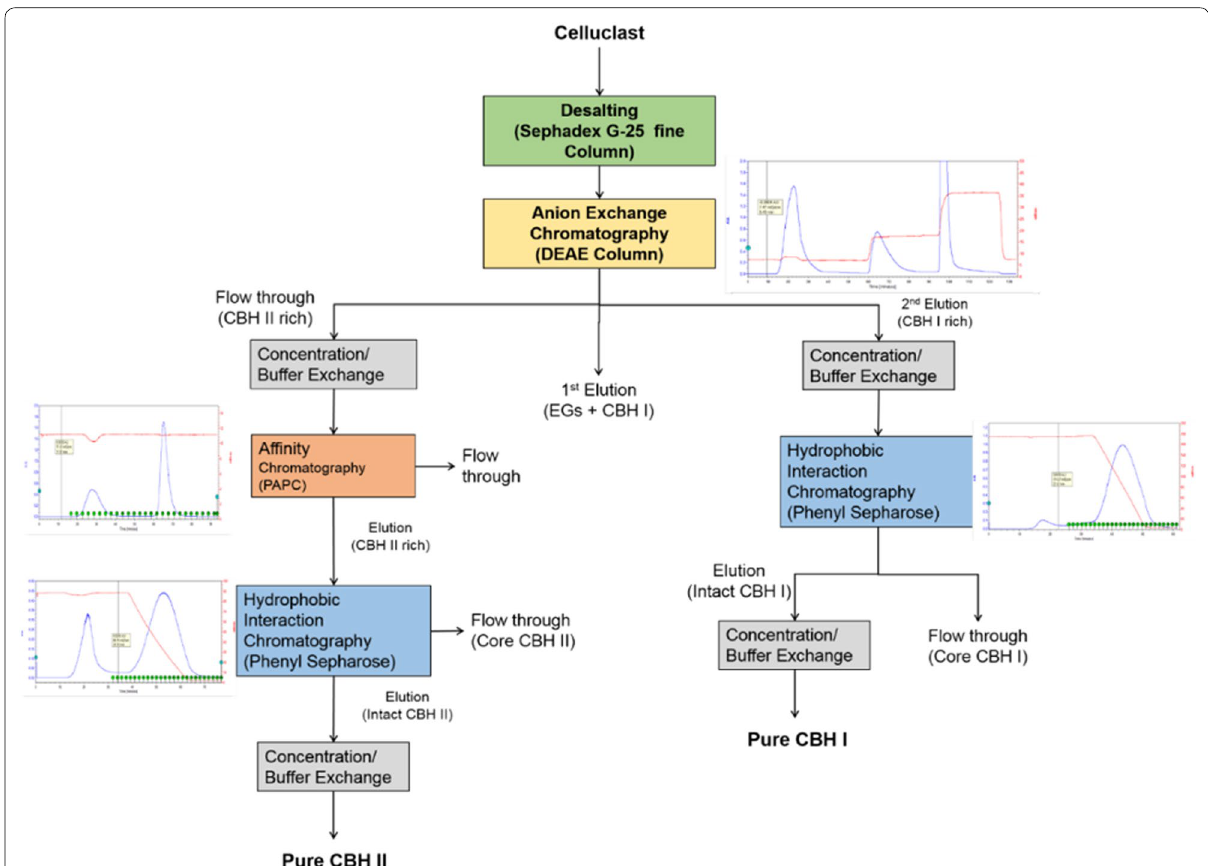
Fig. 4 Flow diagram of the chromatography steps used for purification of the CBH I and CBH II enzymes. Blue lines in the sub-plots refer to absorb- ance at 280 nm and red line refers to